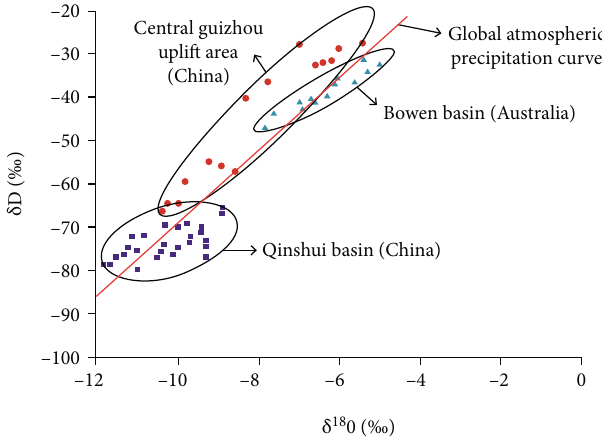
Figure 3: Diagrams of H and O isotopes in coal seam-produced water in di ff erent coal basins in China and Australia [38 –